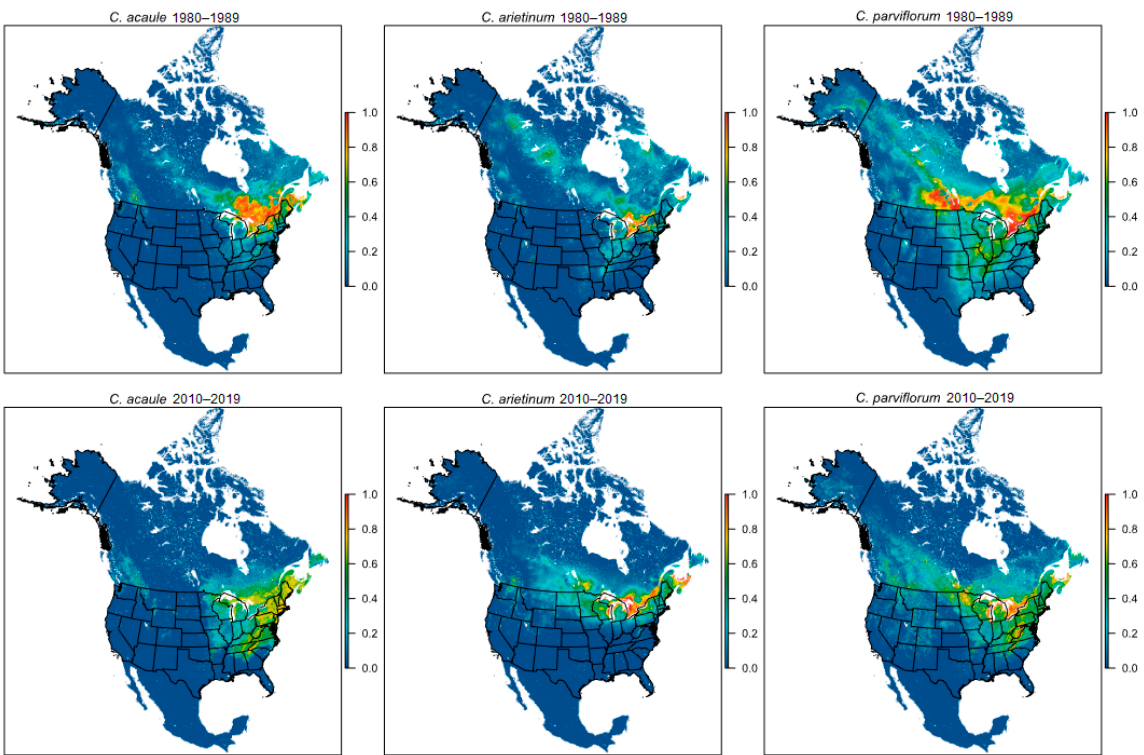
Figure 3. Maps showing M AXENT cloglog prediction of suitable habitat for the three eastern species: C. acaule, C. arietinum, and C. parviflorum . The top row illustrates the ETI prediction and the bottom the LTI. Colors illustrate suitability of habitat, with red indicating optimal habitat and dark blue indicating the least suitable habitat.